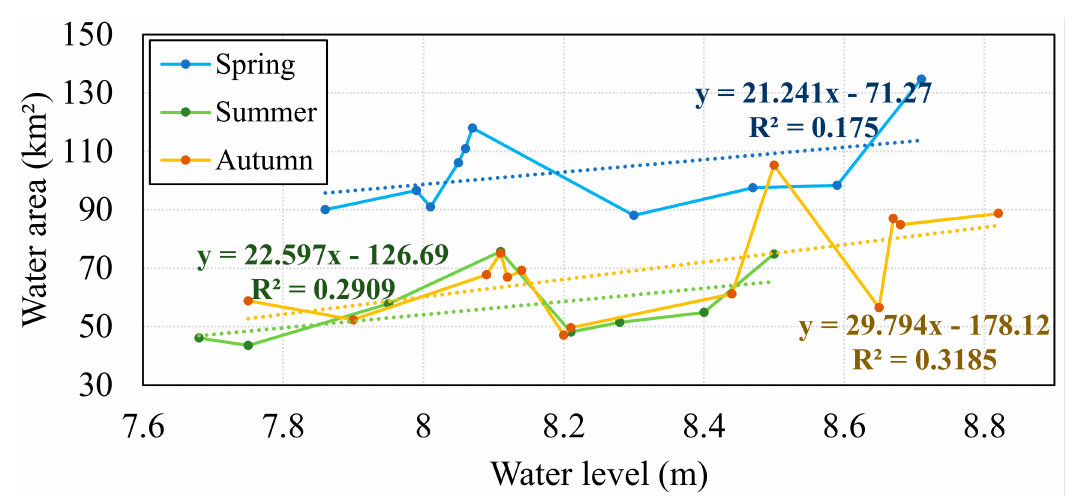
Figure 4. Change of water area with increasing water level in spring, summer, and autumn seasons.